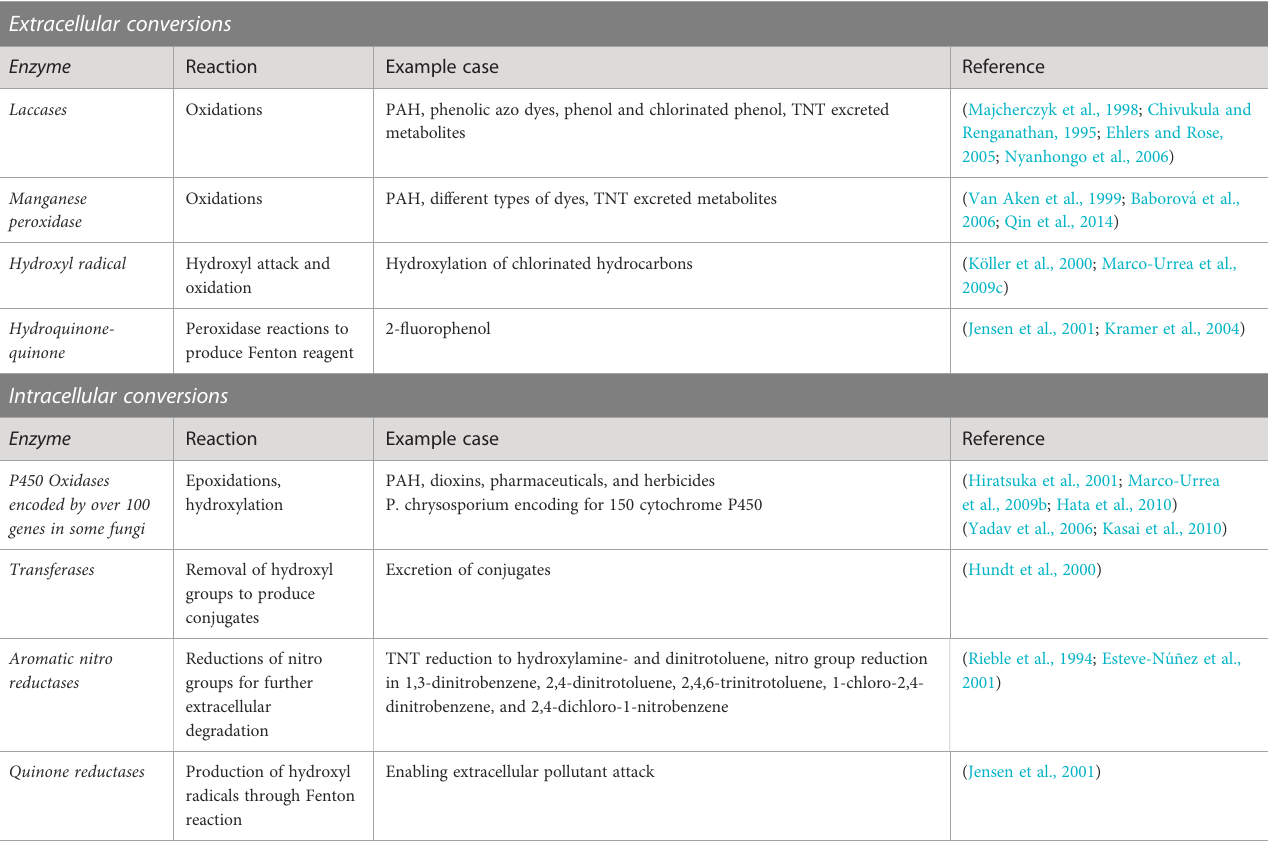
TABLE 1 Summary of extracellular and intracellular mechanisms, only most general mechanisms are exempli fi ed with the most common reactions and case studies. Extracellular